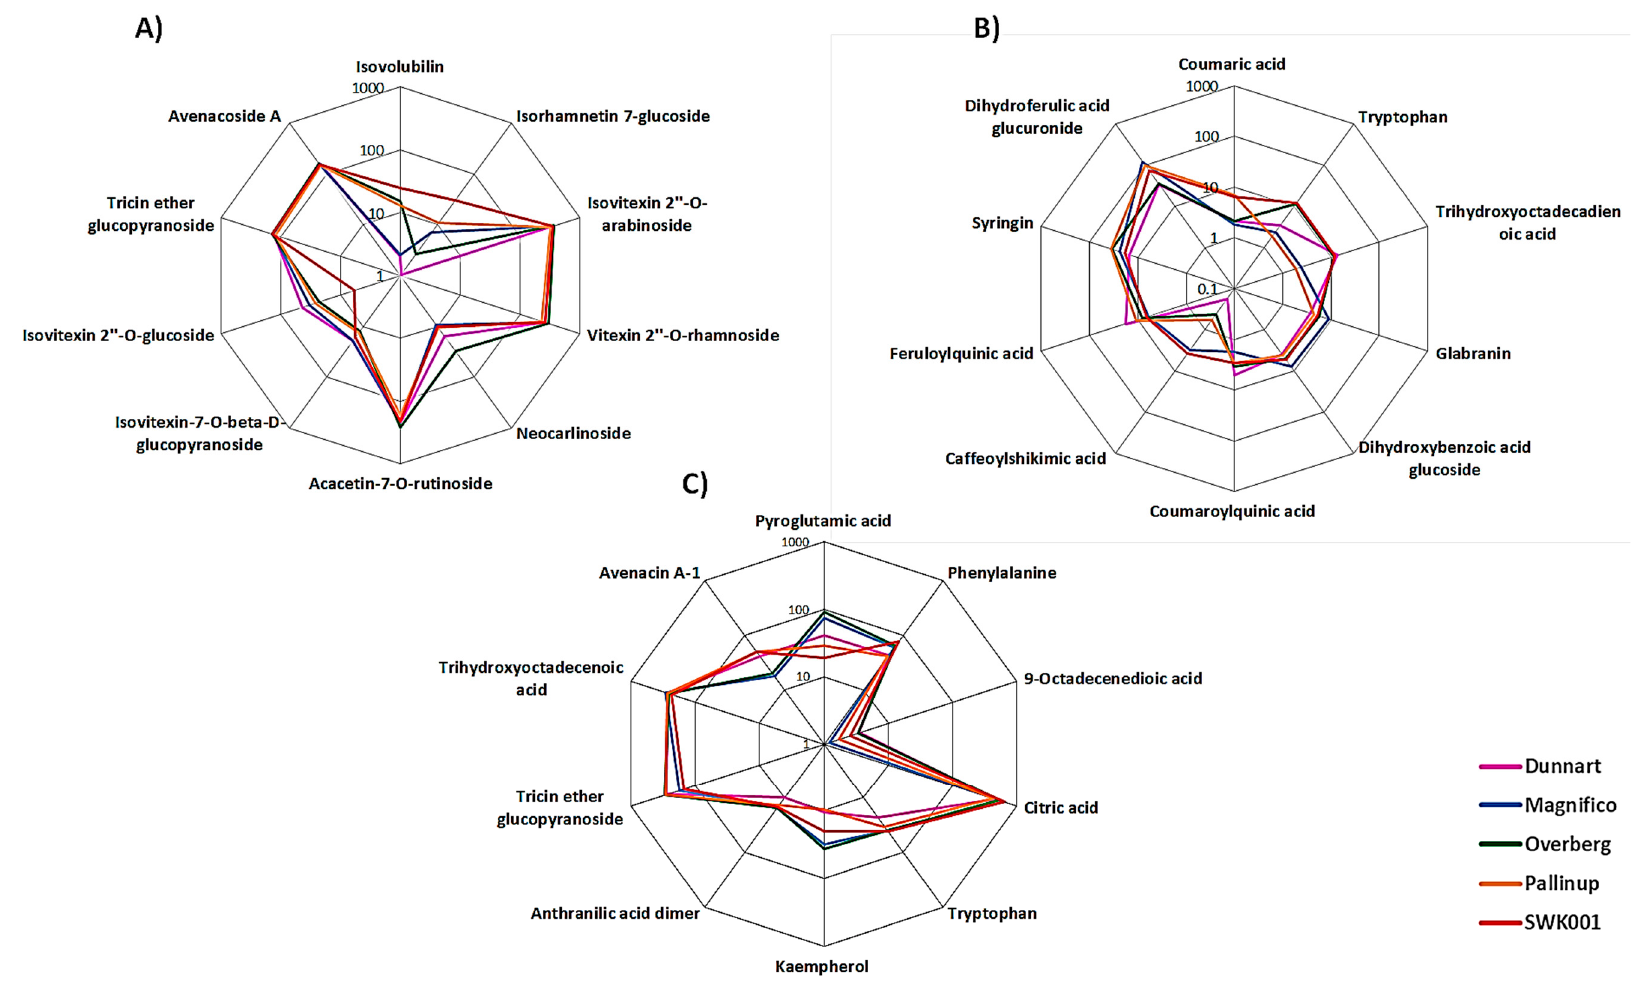
Figure 11. Radar charts illustrating relative intensities of the respective metabolites across the different cultivars in leaf ( A , B ) and root ( C ) tissue. The relative peak intensities were averaged and illustrated as log-transformed values.